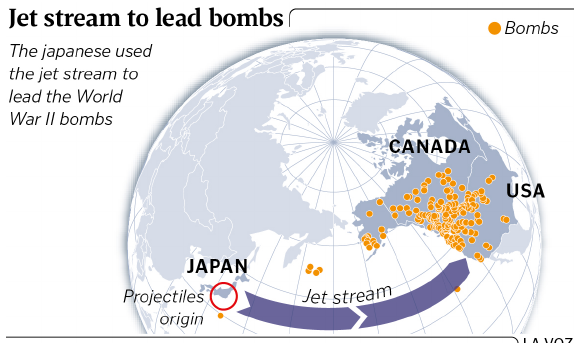
Figure 1. This graphic illustrates how Japanese planes used the jet stream to drop bombs on the United States in the context of World War